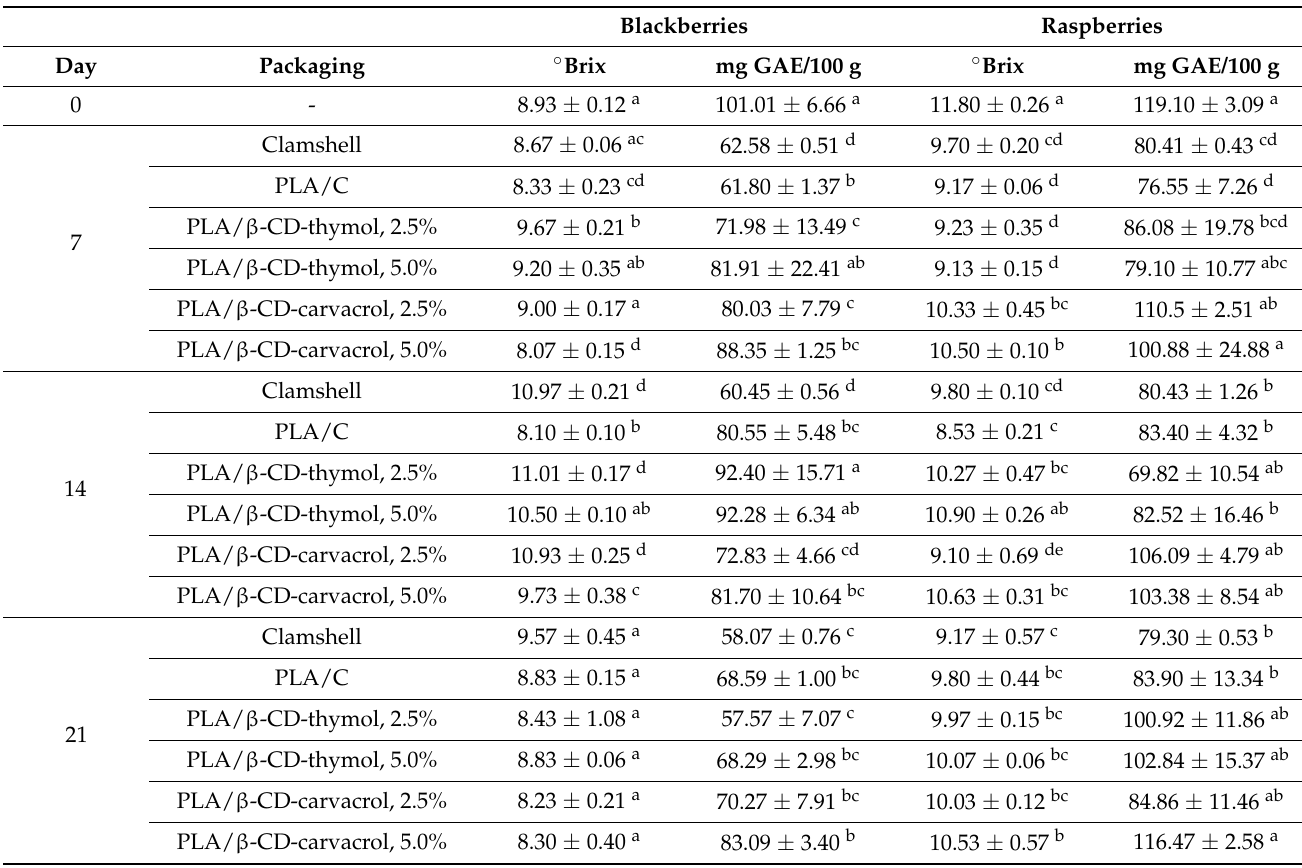
Table 3. Evolution of soluble solid content (SSC) expressed as Brix grade ( ◦ Brix) and total phenolic content (TPC) expressed as milligrams of gallic acid equivalents per 100 g of sample (mg GAE/100 g) of blackberries and raspberries under different packaging at 0, 7, 14, and 21 days of storage at 4 ◦ C. Blackberries